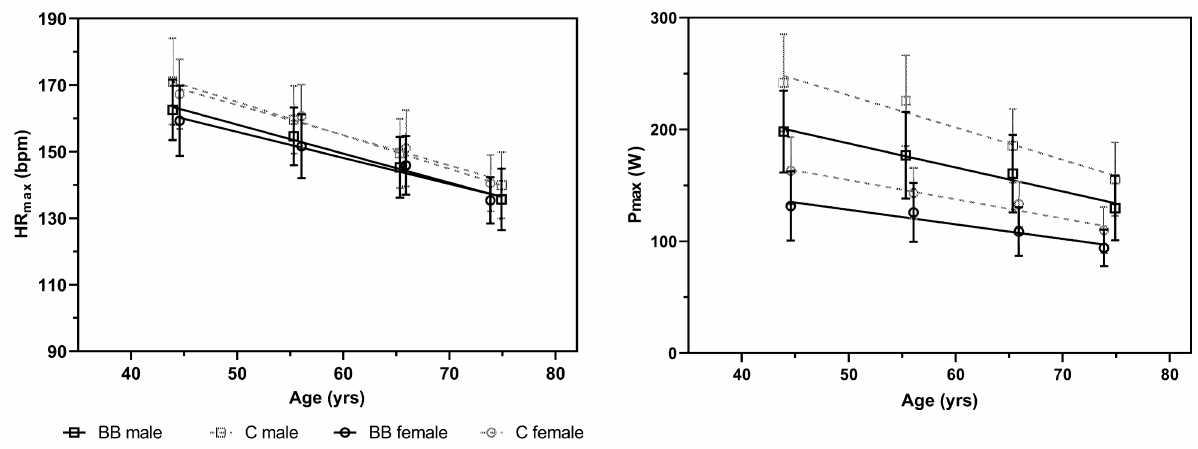
Figure 3. Age related decline of mean maximum heart rate (HR max ) and power output (P max ) in male and female individuals with (BB) and without (C) β -blocker